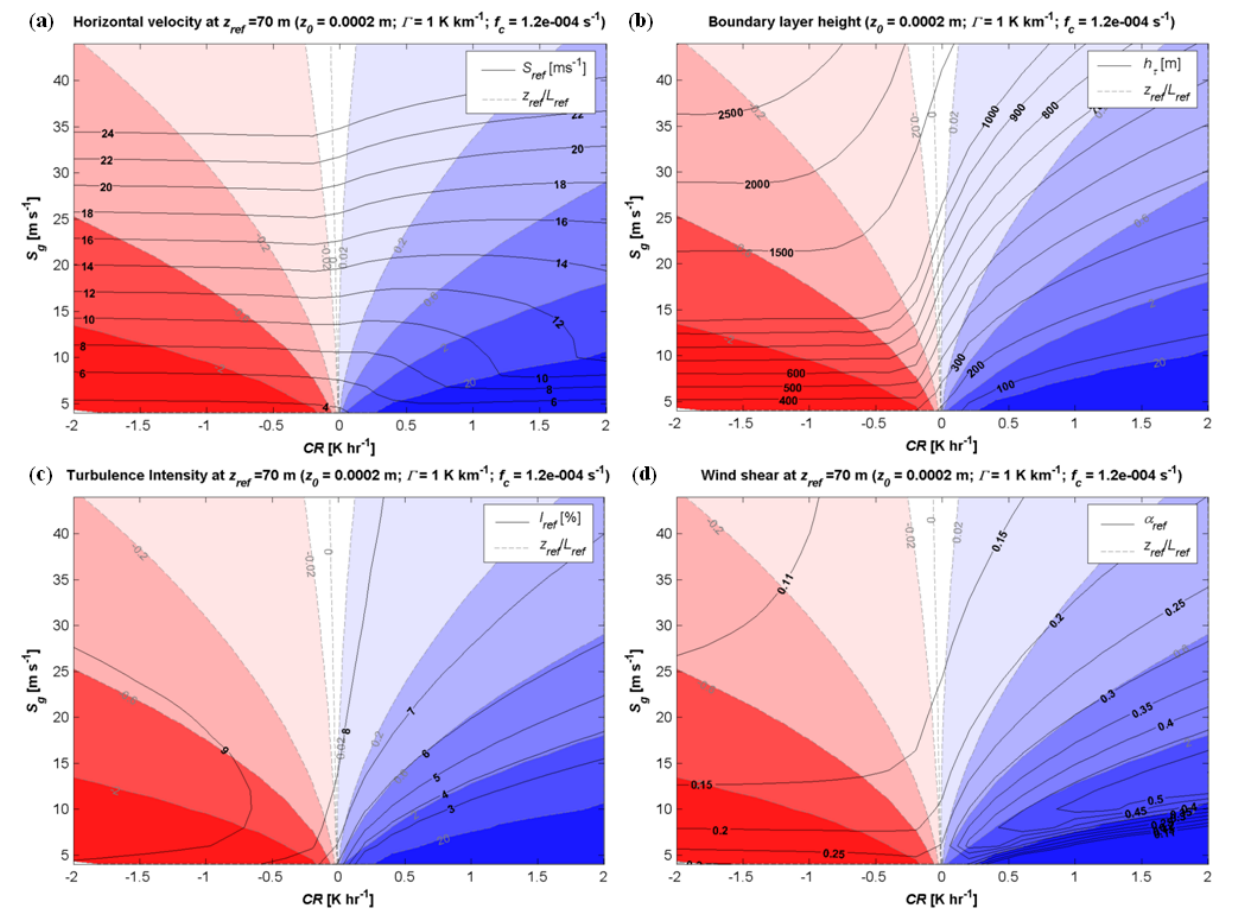
Figure 3. Sensitivity analysis of quasi-steady profiles at different cooling rates CR and geostrophic wind speed S g in offshore conditions ( z 0 ∼ 0.0002m) with an inversion lapse rate of (cid:48) = 1Kkm − 1 . All simulations based on the GABLS1 setup of 9h uniform surface cooling, averaged over the last hour to obtain the quasi-steady profiles. Power-law shear exponent based on 33 and 90m levels. Atmospheric stability based on the local Obukhov parameter ζ = z/L at a reference height of 70m. Stability levels according to Sanz Rodrigo et al. (2014): near neutral (white): 0 <ζ < 0 . 02, weakly stable: 0 . 02 <ζ < 0 . 2, stable 0 . 2 <ζ < 0 . 6, very stable 0 . 6 <ζ < 2, extremely stable ζ > 2 (symmetric range in unstable conditions in